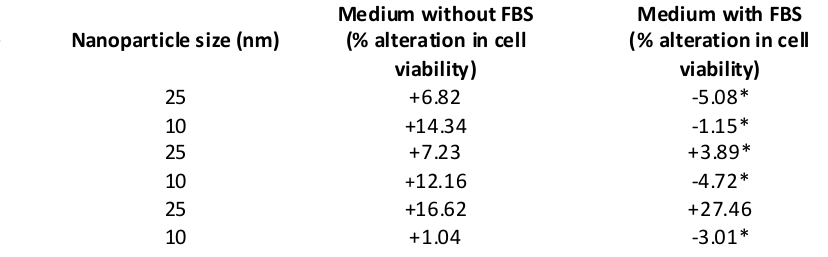
Table 1.: The concentration-dependent effects of 25 nm or 10 nm TiO U937 and IM9 cells which were cultured in FBS-containing or FBS-free medium. Values indicated the differ- ences of viability between 0.2 m g/ml and 100 m g/ml ten different concentrations of TiO bation period. *p < 0.05; comparison of % alteration in cell viability between medium without FBS and with